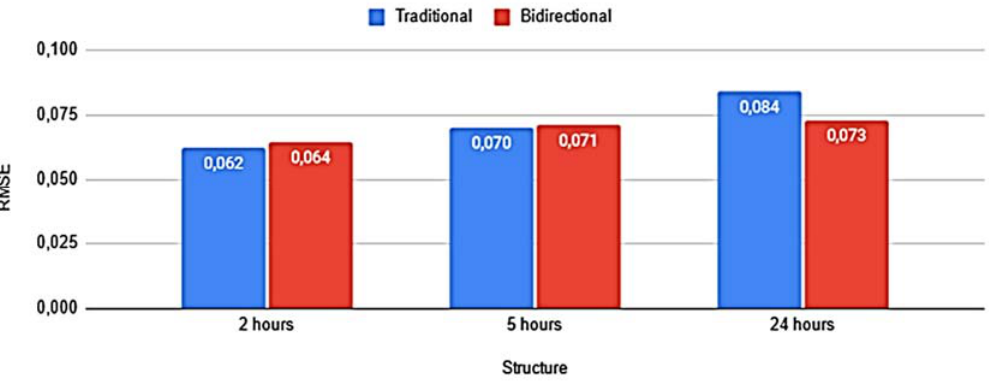
Figure 26. Average RMSE trend concerning time horizon by structure for the validation set.